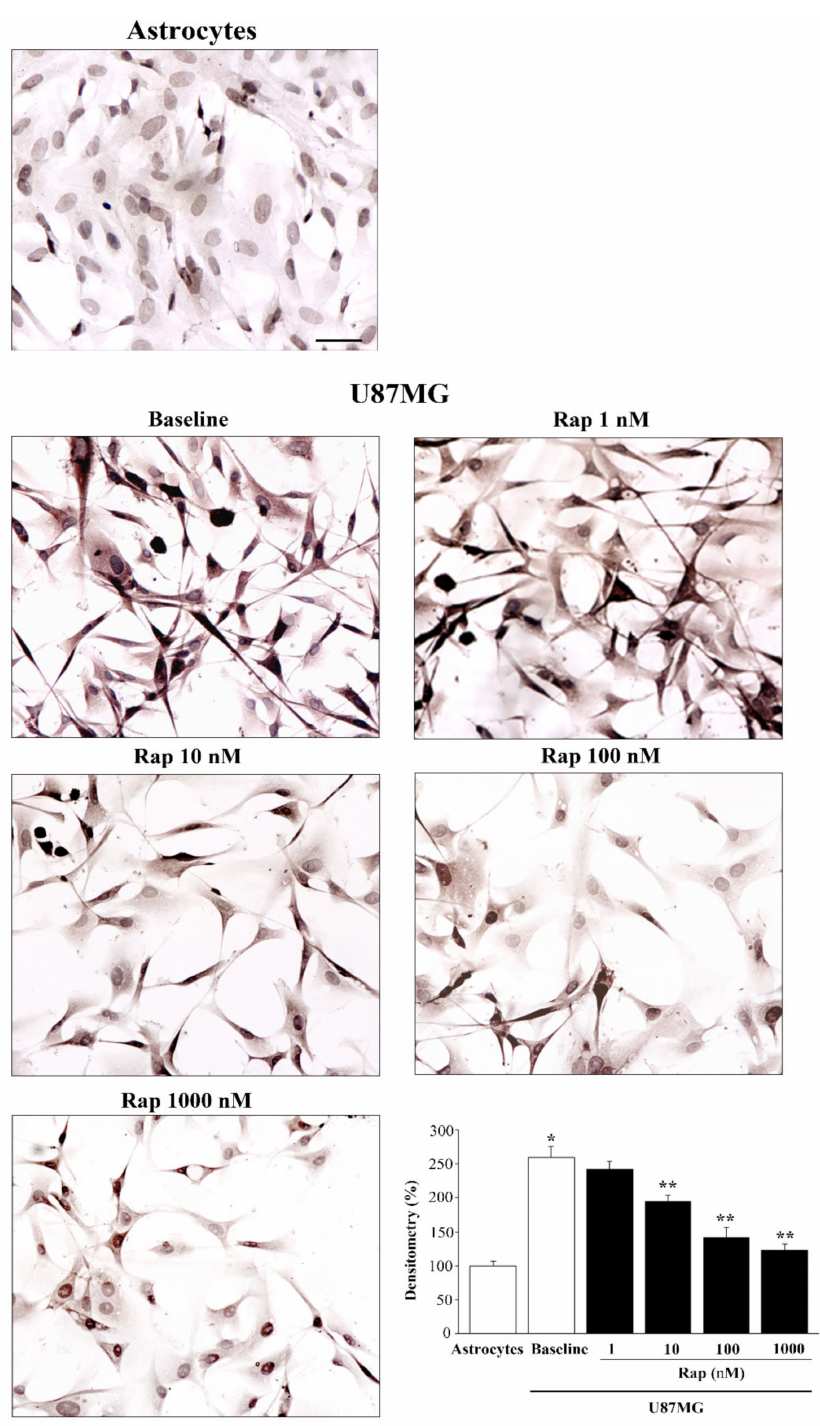
Figure 6. Rapamycin dose-dependently reduced α -syn-immunostaining. Representative pictures of α -syn immuno-positive astrocytes and U87MG cells in baseline conditions and following rapamycin (Rap) administration. The graph reports densitometry for α -syn immunostaining within astrocytes compared with U87MG cells, in baseline conditions and following rapamycin administration. Data are given as the mean percentage ± SEM of optical density from n = 30 cells obtained in N = 3 independent experiments (assuming the controls to be 100%). * p < 0.05 compared with astrocytes; ** p < 0.05 compared with baseline and Rap 1 nM. Scale bar = 22.5 µ